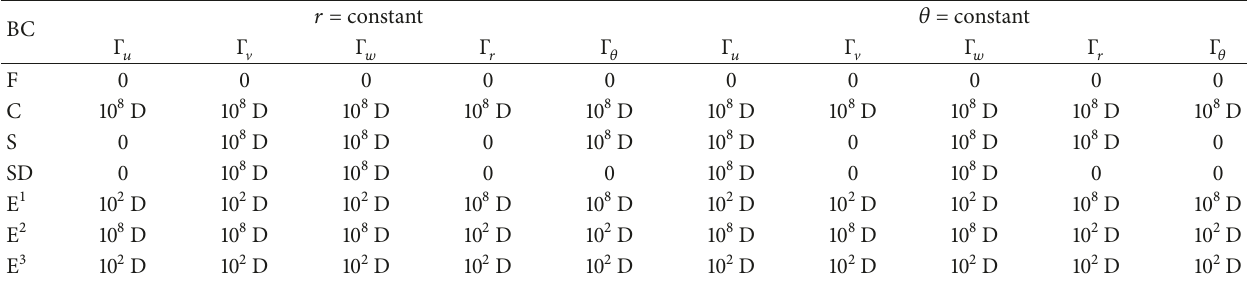
Table 1: The corresponding elastic restraint parameters for various boundary